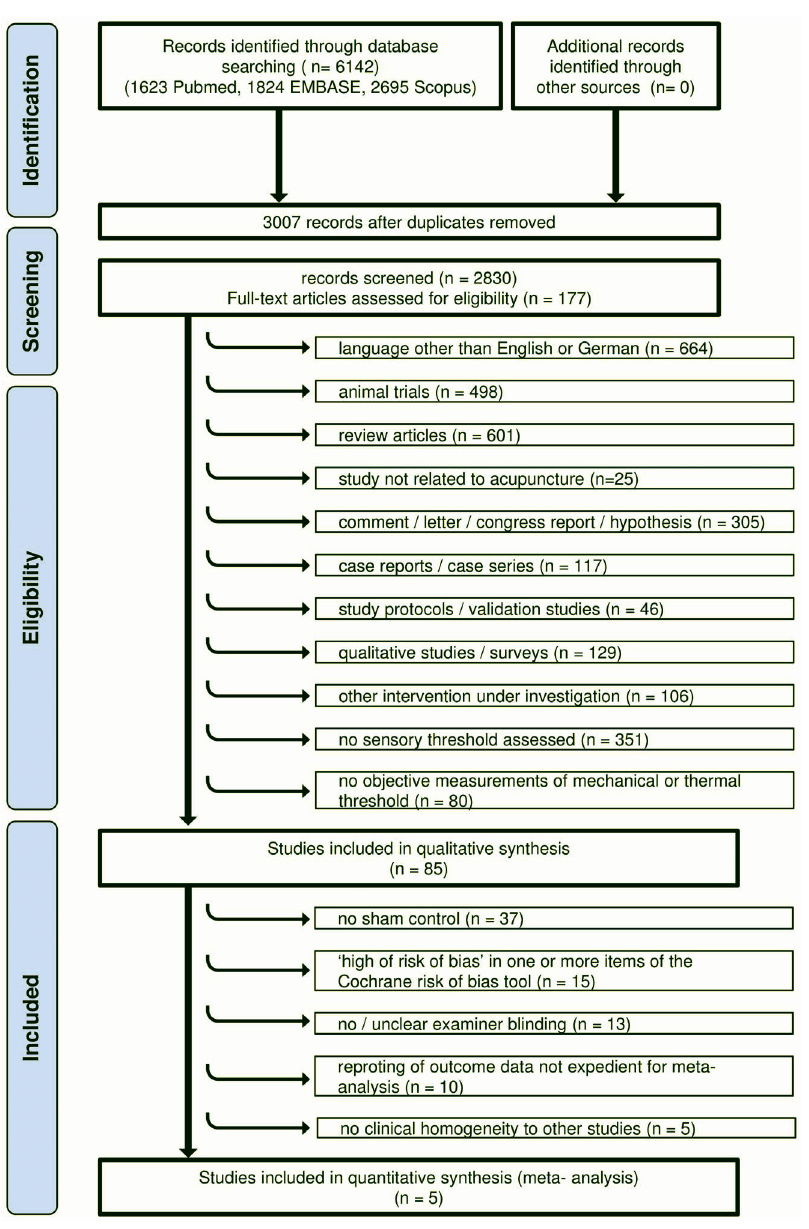
Fig. 1. Systematic Review Process